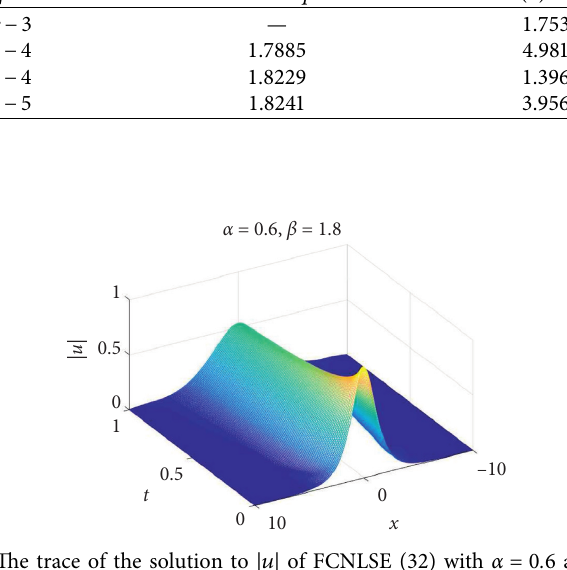
Table 2: Temporal convergence rates of the two-step ETD scheme with Pad´e approximation for FCNLSE (32) with α � 0 . 8. τ err ( τ ) for β � 1 . 4